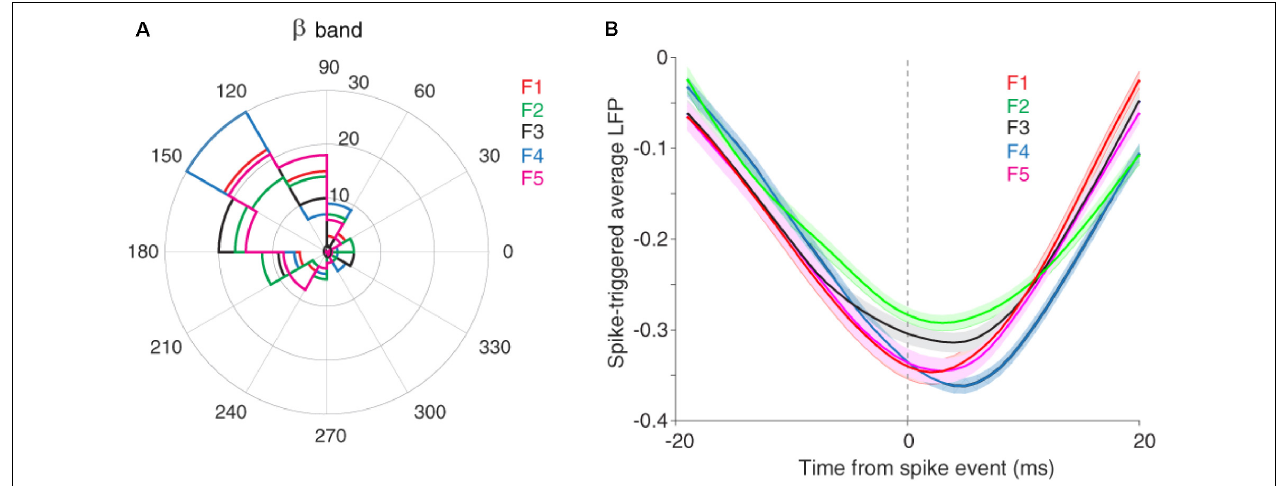
FIGURE 3 | The preferred LFP phase. (A) The LFP phase histograms of different stimuli (f1–f5) within the beta range (13–30 Hz), show approximately identical locking phase mean of ∼ 140 ◦ for five desired tone frequencies. (B) STA calculated across all recording sites and for each five desired tone frequencies